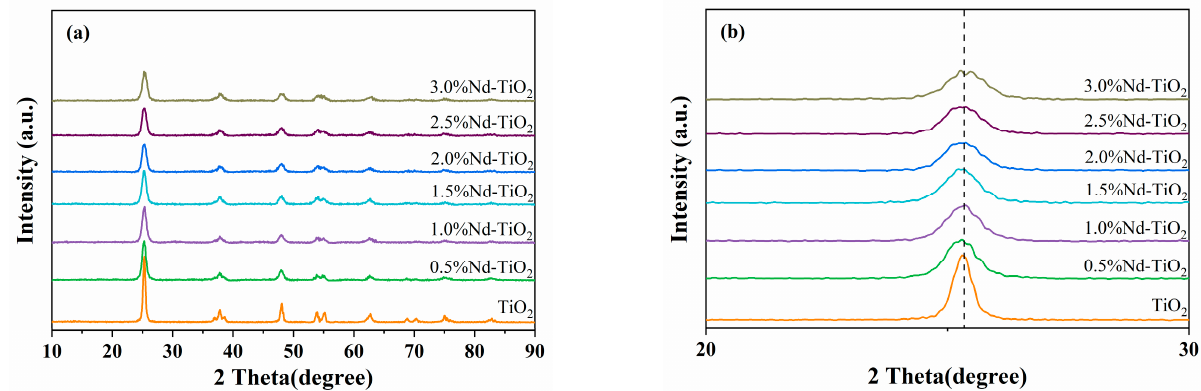
Figure 1. ( a ) XRD patterns of the TiO 2 and Nd-TiO 2 NPs with different Nd 3+ concentrations. ( b ) The enlarged XRD spectra in the plane peak at (101) plane.